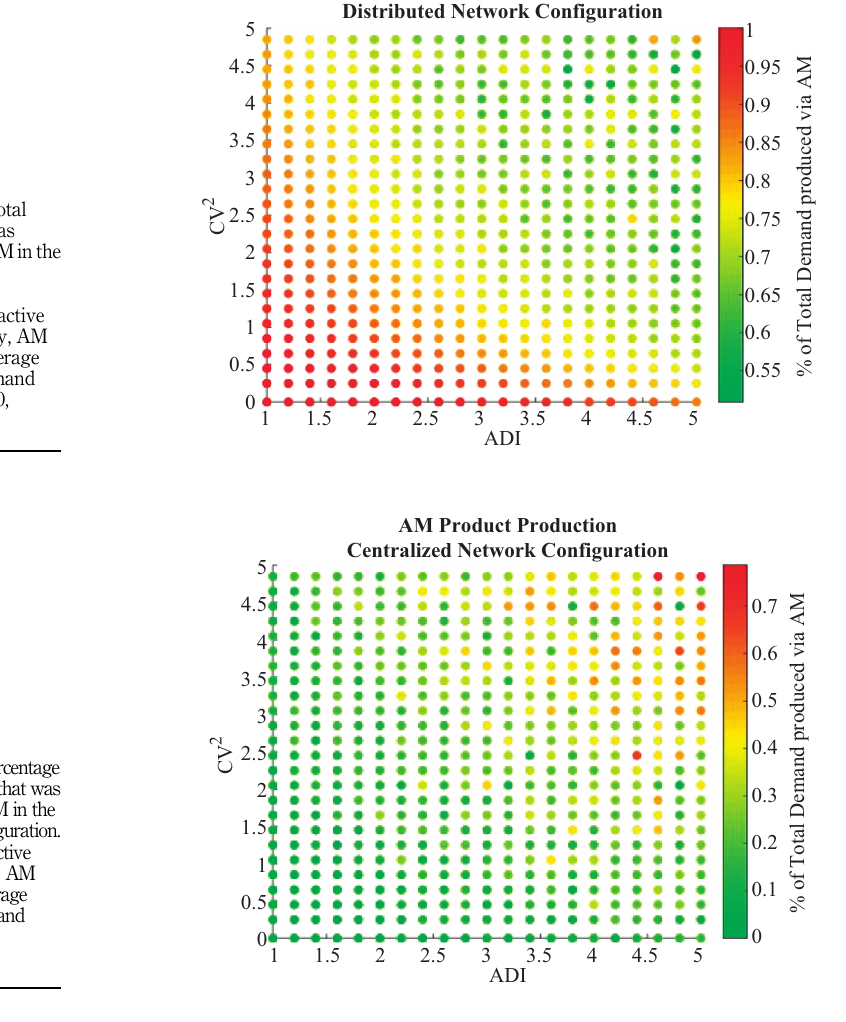
Figure A1. (Color online) Percentage of total demand that was producedviaAMinthe distributed configuration. (Parameters: reactive inventory policy, AM capacity: 4, Average demand: 3, Demand realizations: 500,